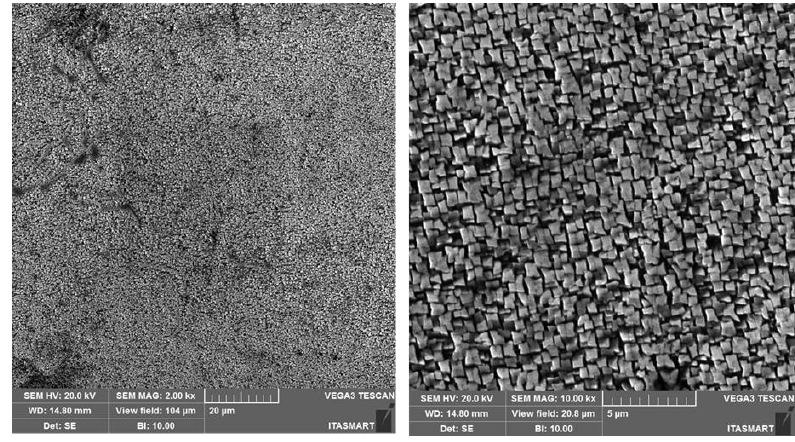
Figure 5. SEM of the as cast condition.